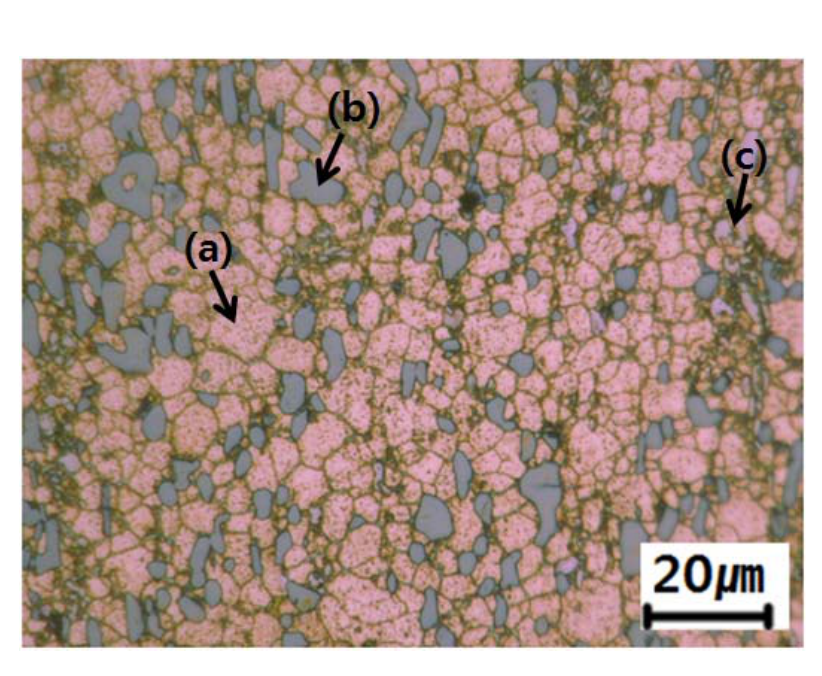
Figure 1. Optical micrograph of the cross ‐ section for as ‐ received alloy.